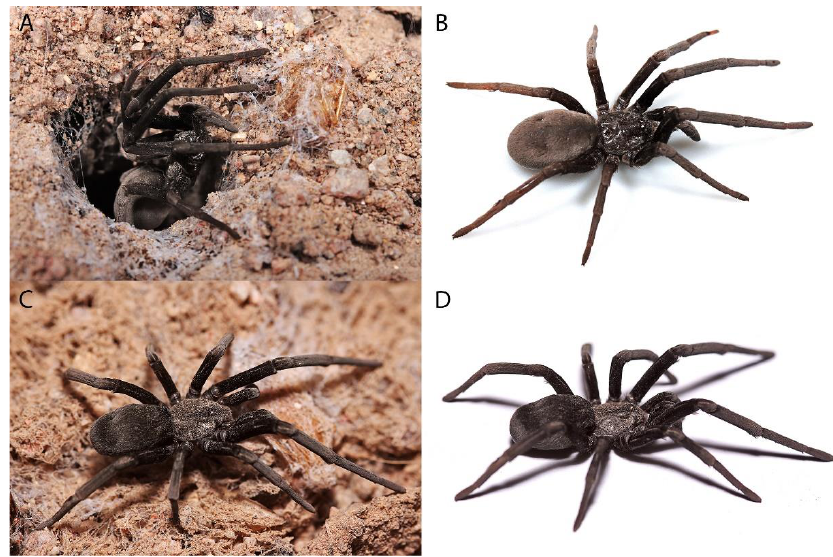
Figure 11. Sahastata aravaensis sp. nov. habitus of live spiders in laboratory. ( A , B ): paratype MACN-Ar 41837, Pictures: Ivan L. F. Magalhaes, ( C , D ): paratype HUJI-AR 21001 , Pictures: Shlomi Aharon.